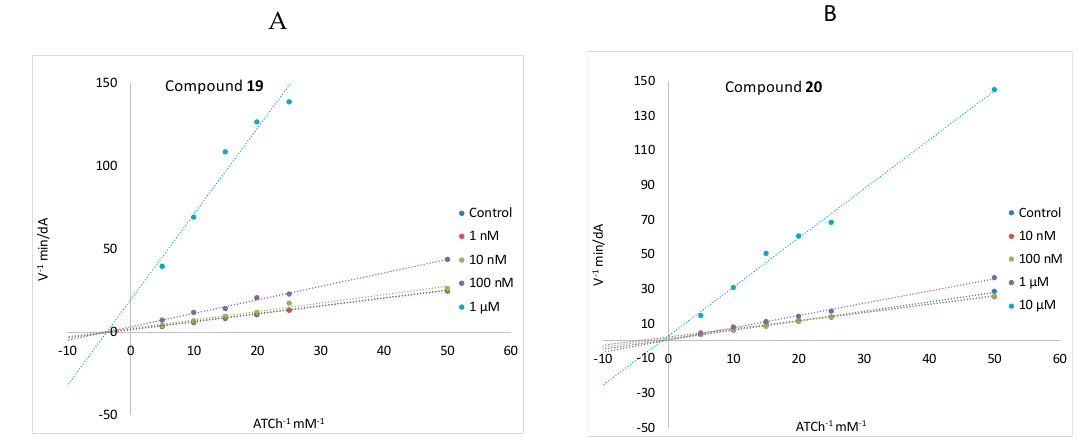
Figure 5. Lineweaver-Burk plots of inhibition kinetics show that 19 acts as a non-competitive AChE inhibitor ( A ) and 20 as a mixed-type AChE inhibitor ( B ).